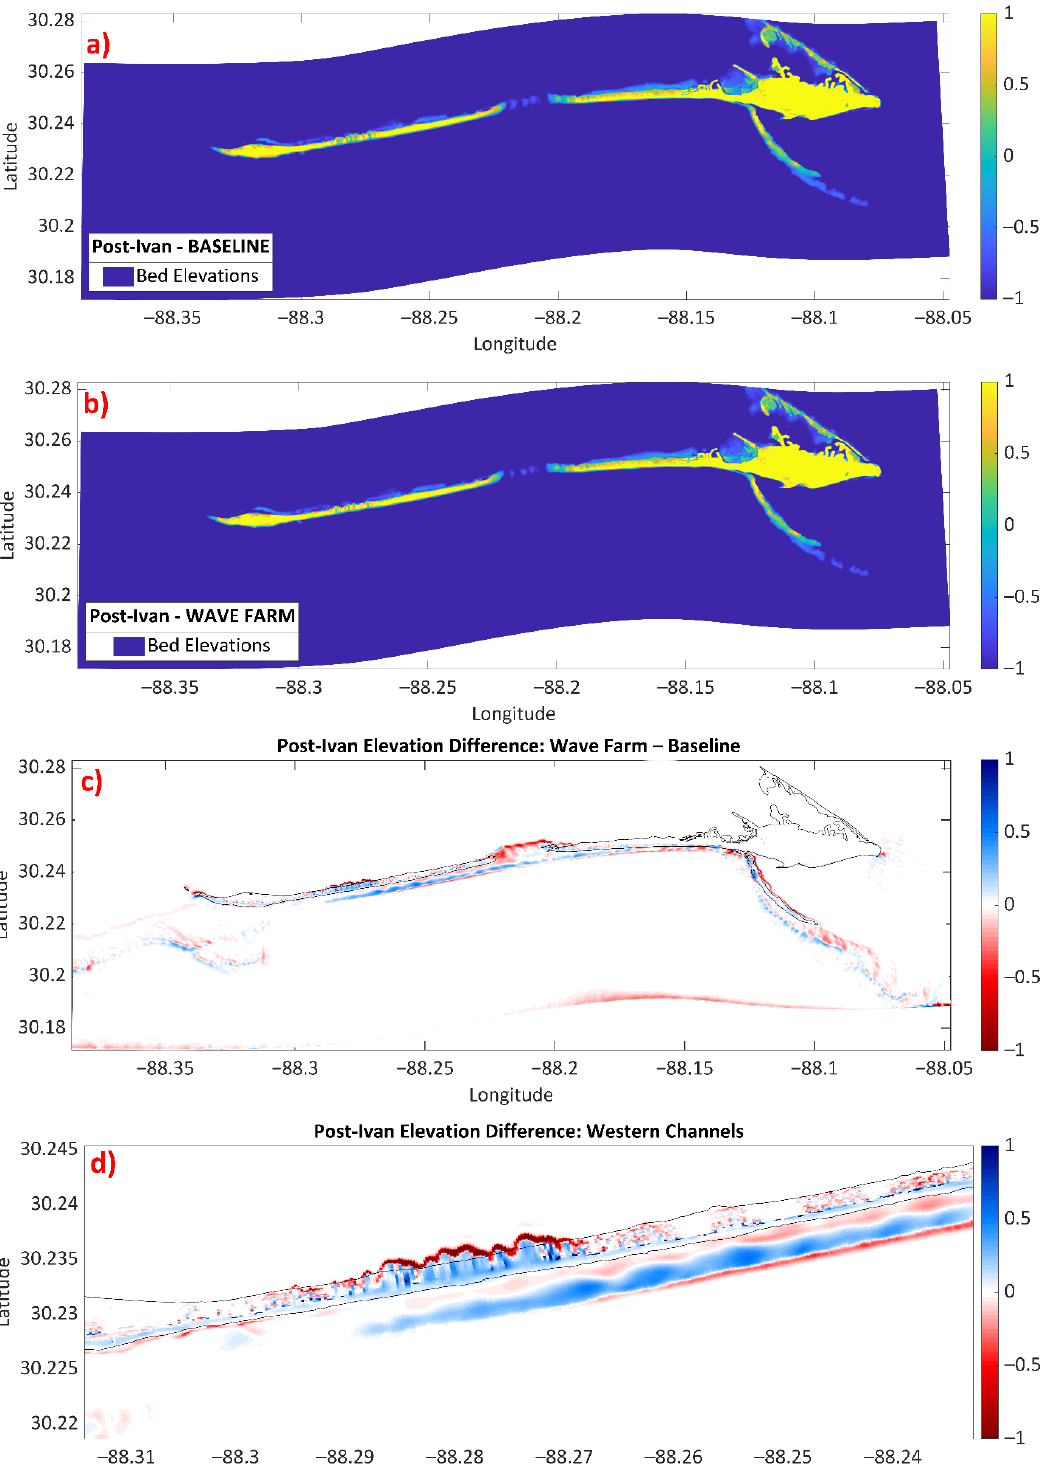
Figure 9. Final bed elevations [m] for baseline ( a ) and wave farm ( b ) scenarios on Dauphin Island, AL. ( c ) Difference between the two scenarios. ( d ) Magnified version of ( c ) showing the channels in the western portion—Positive (blue) values show the locations where the final elevations are higher in the wave farm scenario. The black line is the poststorm zero-meter contour of the island. To quantify the impacts of the wave farm on coastal sediment, we present the results of the inundated area, volume loss, and bed shear stress calculations for both scenarios in Table 1. The initial area and volume of the island are identified by determining the dry and wet cells within the computational domain. The zero-meter contour is identified, and initial area and volume values are calculated based on the cells that fall into the zero-meter polygon. Maximum water levels that occurred throughout the simulation are determined for each cell, and they are compared to the initial and final bathymetry (i.e., z-value) to determine the inundated cells for volume loss calculations. We find that the poststorm subaerial island area and subaerial sand volume are higher when the WECs are present. Additionally, the total inundated area and net loss in the sand volume are lower in the wave farm scenario. Results indicate a 15% reduction in the net loss of sand volume due to the wave farm. Bed shear stress is used as another indicator of erosion at the bed level, as the likeli- hood of ocean bottom sediment to be mobilized is directly correlated with the intensity of bed shear stress [40,65]. XBeach calculates the bed shear stress associated with the long waves and mean currents using the following formulation in the cross-shore; x-( 𝜏 (cid:3029)(cid:3051) ) and alongshore; y-( 𝜏 (cid:3029)(cid:3052) ) directions [53]: 𝜏 (cid:3029)(cid:3051) = 𝑐 (cid:3033) 𝜌𝑢 (cid:3006) (cid:3493)(cid:4666)1.16 𝑢 (cid:3045)(cid:3040)(cid:3046) ) (cid:2870) + (cid:4666)𝑢 (cid:3006) + 𝑣 (cid:3006) ) (cid:2870)